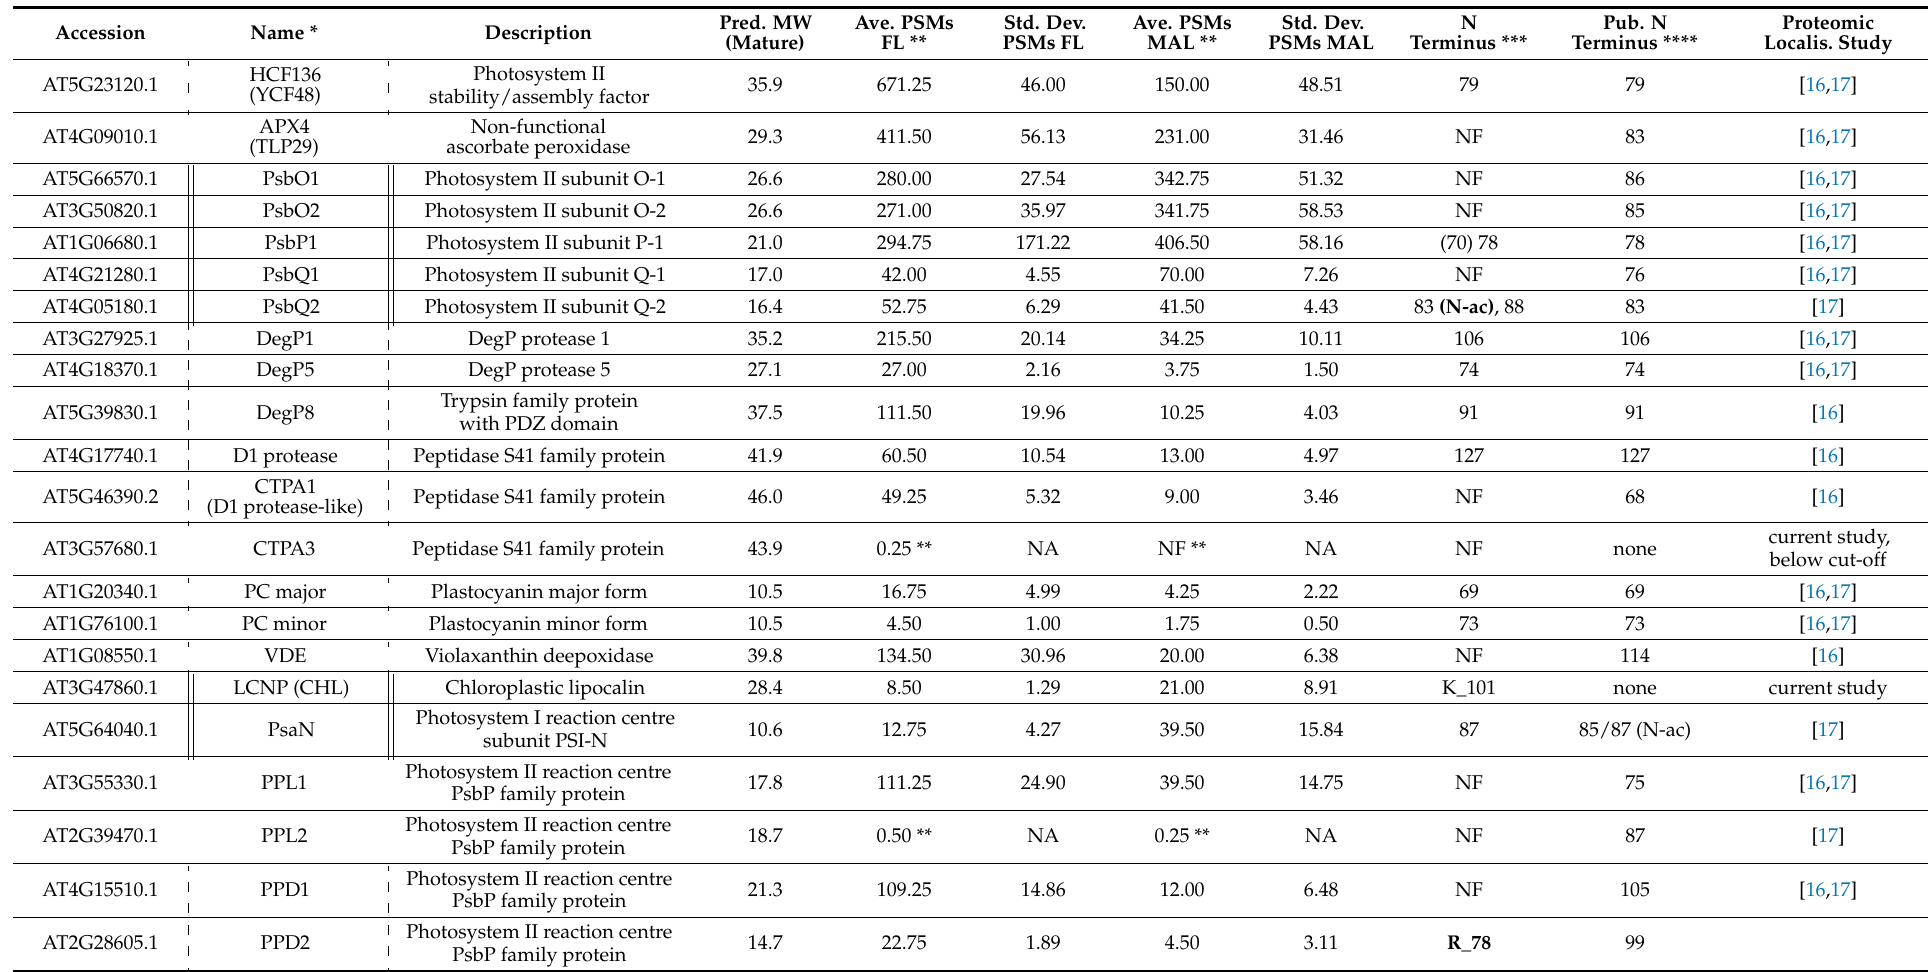
Table 1. Lumen proteins identified in the free lumen (FL) and membrane-associated lumen (MAL) by mass spectrometry-based